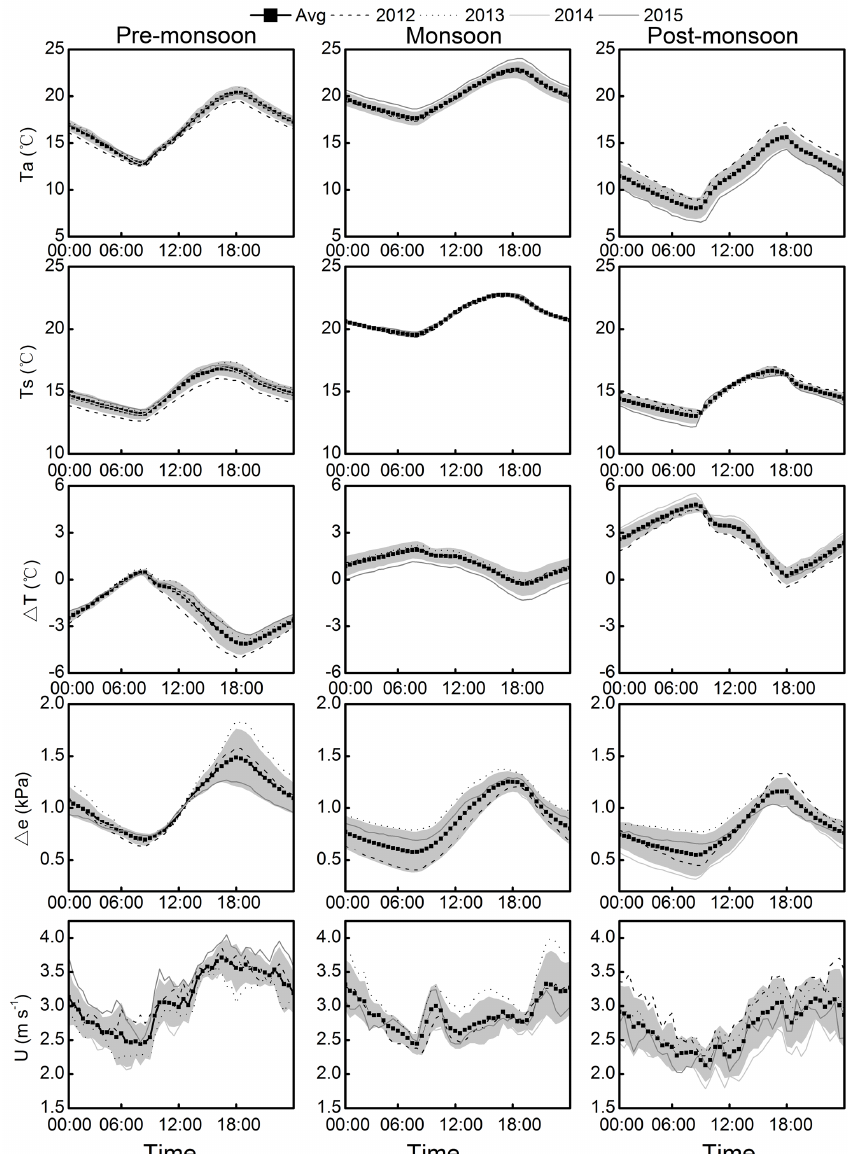
Figure 3. The average diurnal pattern of air temperature ( T a ), water surface temperature ( T s ), difference between water surface temperature and air temperature ( (cid:49)T ), water–air vapor pressure deficit ( (cid:49)e ) and wind speed ( U ) during pre-monsoon, monsoon and post-monsoon periods from 2012 to